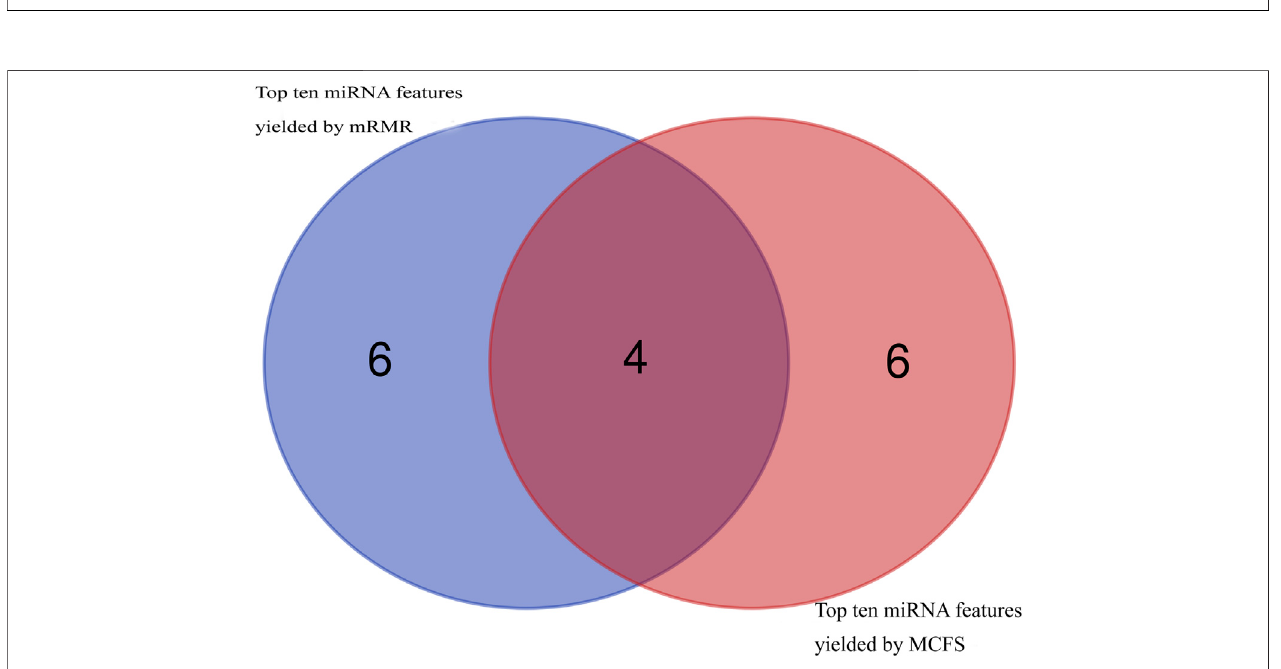
FIGURE 2 | Venn diagram to show top ten miRNA features obtained by mRMR and MCFS methods. Four miRNA features are commonly identi fi ed.